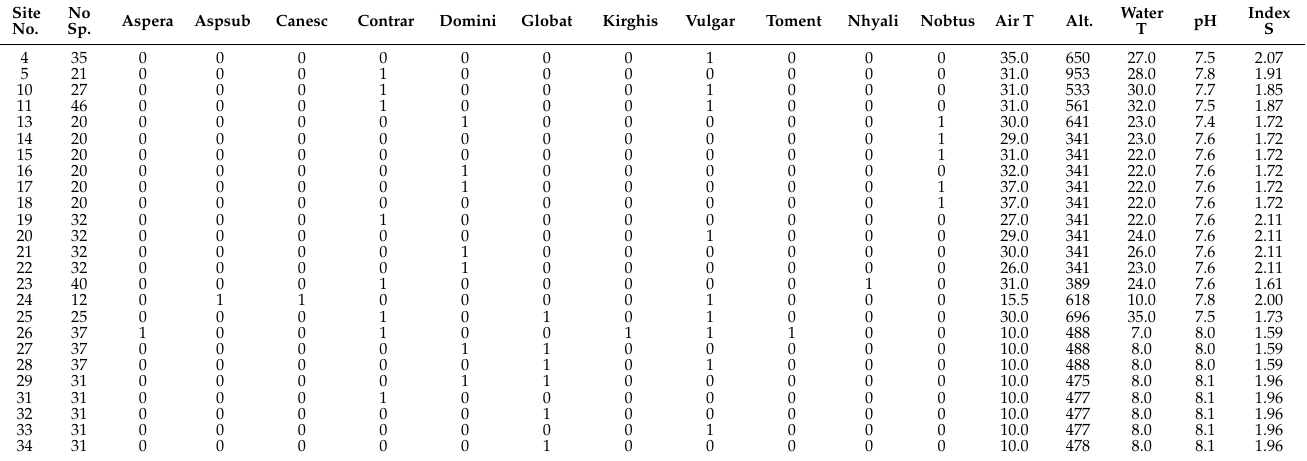
Table A2. Data for species, average species richness in community [8], environmental variables of water and air in studied sites of south and southeast Kazakhstan, 2019–2022. Abbrevia- tions: aspera— Chara aspera var. aspera , aspsub— C. aspera var. subinermis , canesc— C. canescens , contrar— C. contraria , domini— C. dominii , globat— C. globata , kirghis— C. kirghisorum , vulgar— C. vulgaris , toment— C. tomentosa , Nhyali— Nitella hyalina , Nobtus— Nitellopsis obtusa , No Sp.—species number of microalgae in community. The environmental data were performed only for those 34 sites where complete environmental data were